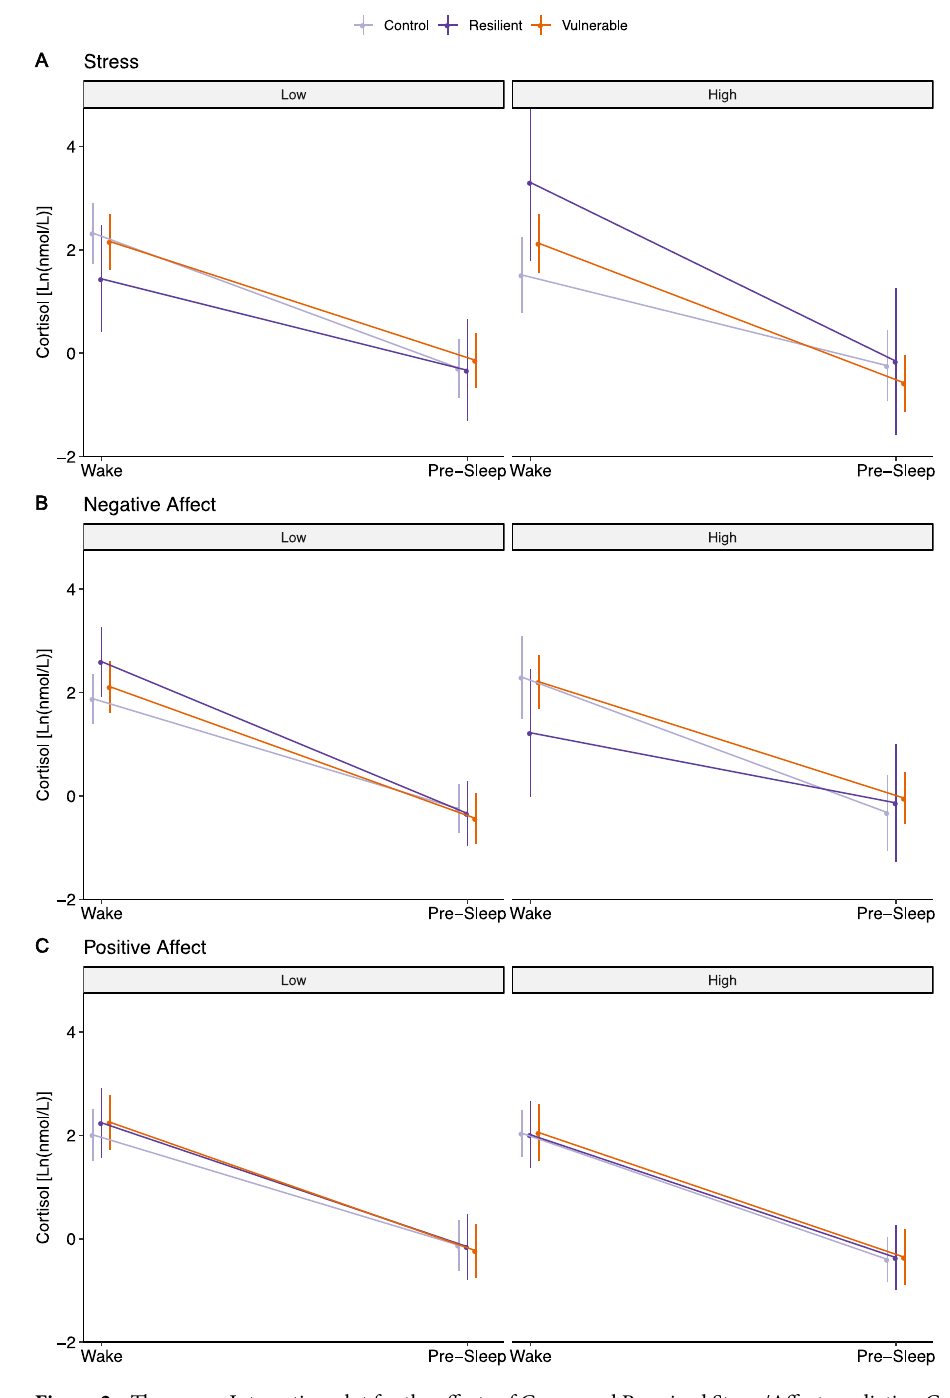
Figure 2. Three-way Interaction plot for the effects of Group and Perceived Stress/Affect predicting Cortisol Diurnal Slope. High and Low conditions of perceived stress (4.24, 0.45), negative (2.06, 1.04) and positive affect (1.57, 3.64) were determined based on the 90% and 10% percentile values of these variables within our